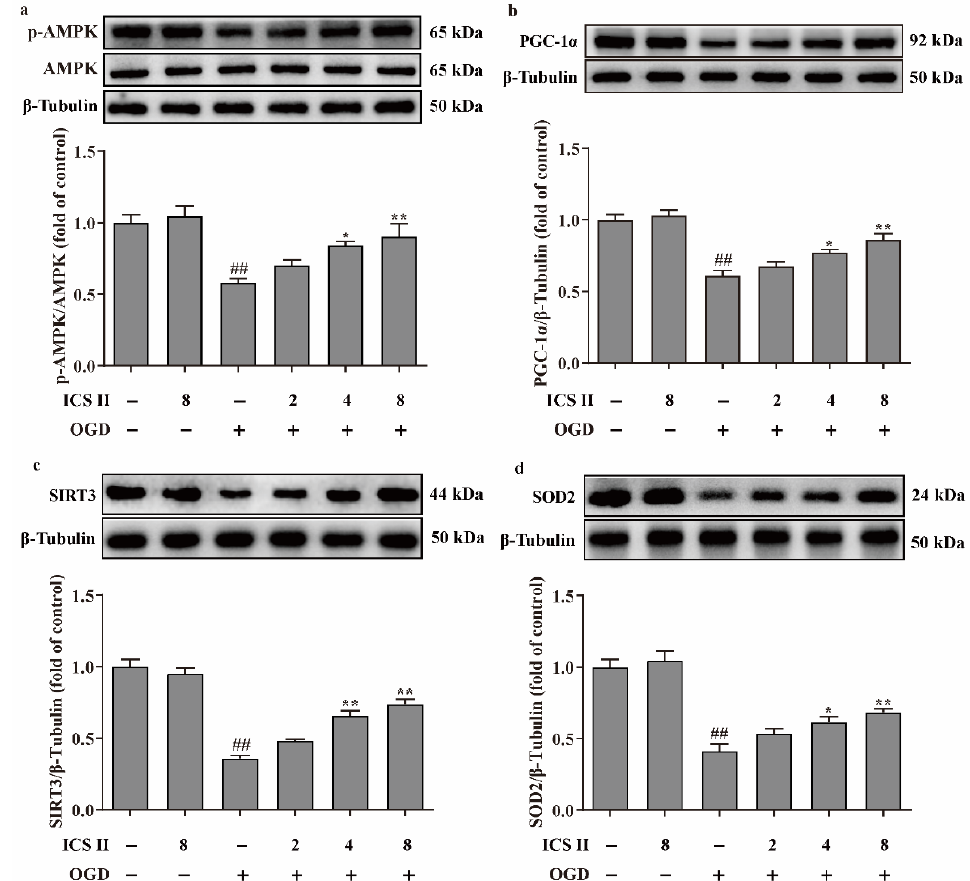
Figure 7. ICS II activated AMPK/PGC-1 α /SIRT3 signaling pathway in OGD-induced cardiomyocytes injury: ( a ) Expression and quantitation of p-AMPK ( n = 5); ( b ) expression and quantitation of PGC- 1α ( n = 5); ( c ) expression and quantitation of SIRT3 ( n = 5); ( d ) expression and quantitation of SOD2 ( n = 5). The data are presented as the mean ± SEM. ## p < 0.01 vs. control; * p < 0.05, ** p < 0.01 vs. OGD.